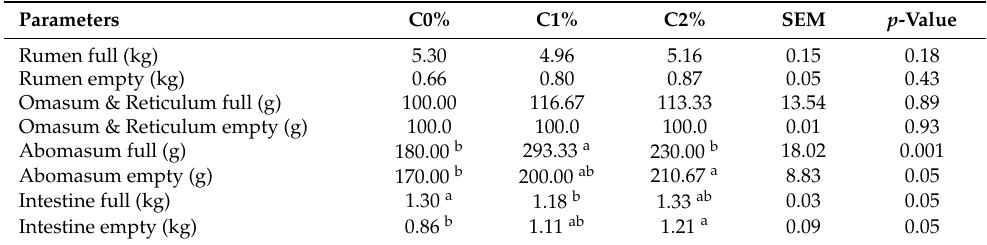
Table 3. Effect of different levels of corn on weight of component of full and empty gastrointestinal tract.